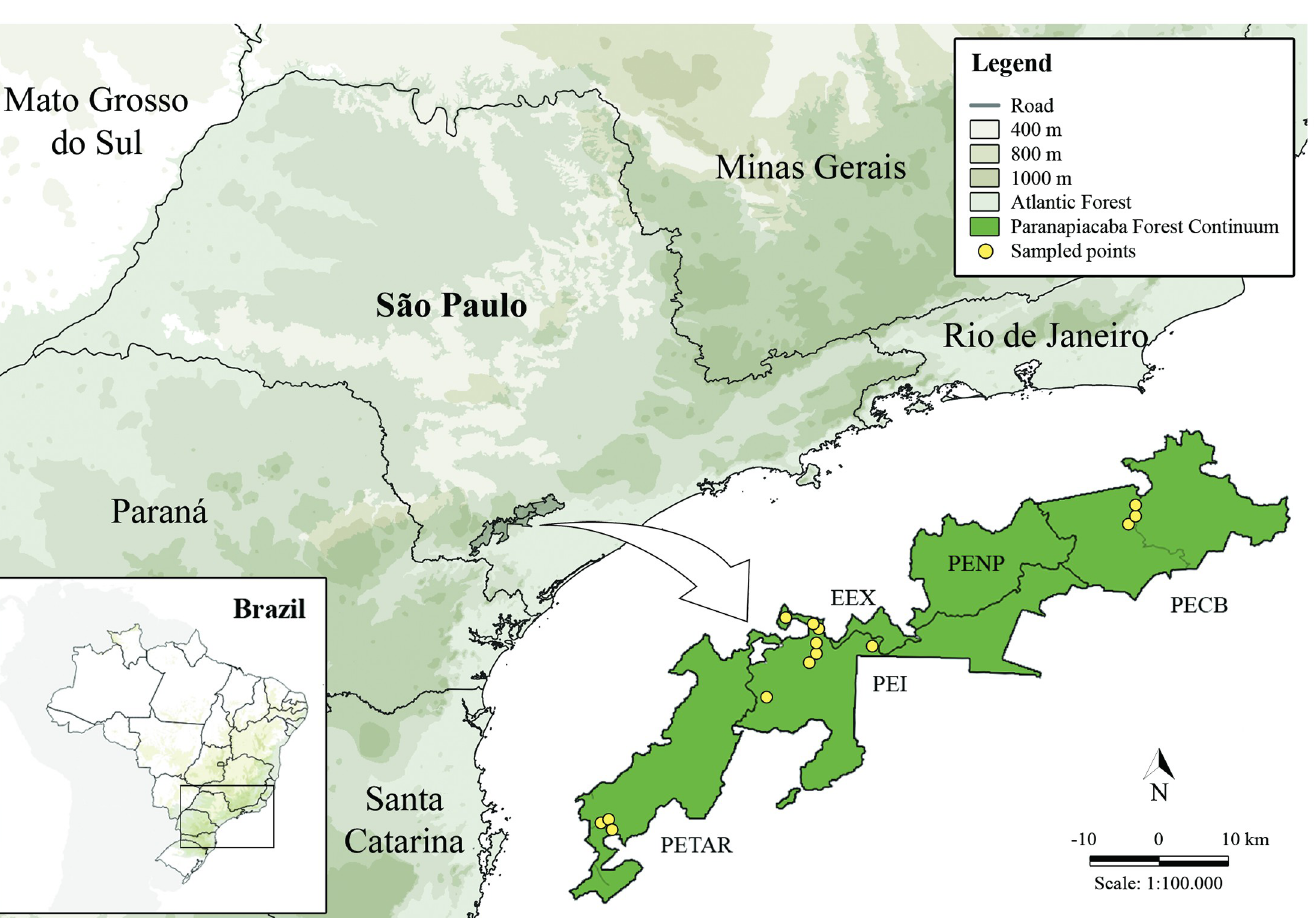
Fig 1. Paranapiacaba Mountains. Map of Paranapiacaba Forest Continuum and the sampled sites. EEX: Ecological Station of Xitue´; PECB: Carlos Botelho State Park; PEI: Intervales State Park; PENP: Nascentes do Paranapanema State Park; and PETAR: Alto Ribeira Tourist State Park, S ã o Paulo State, Brazil.